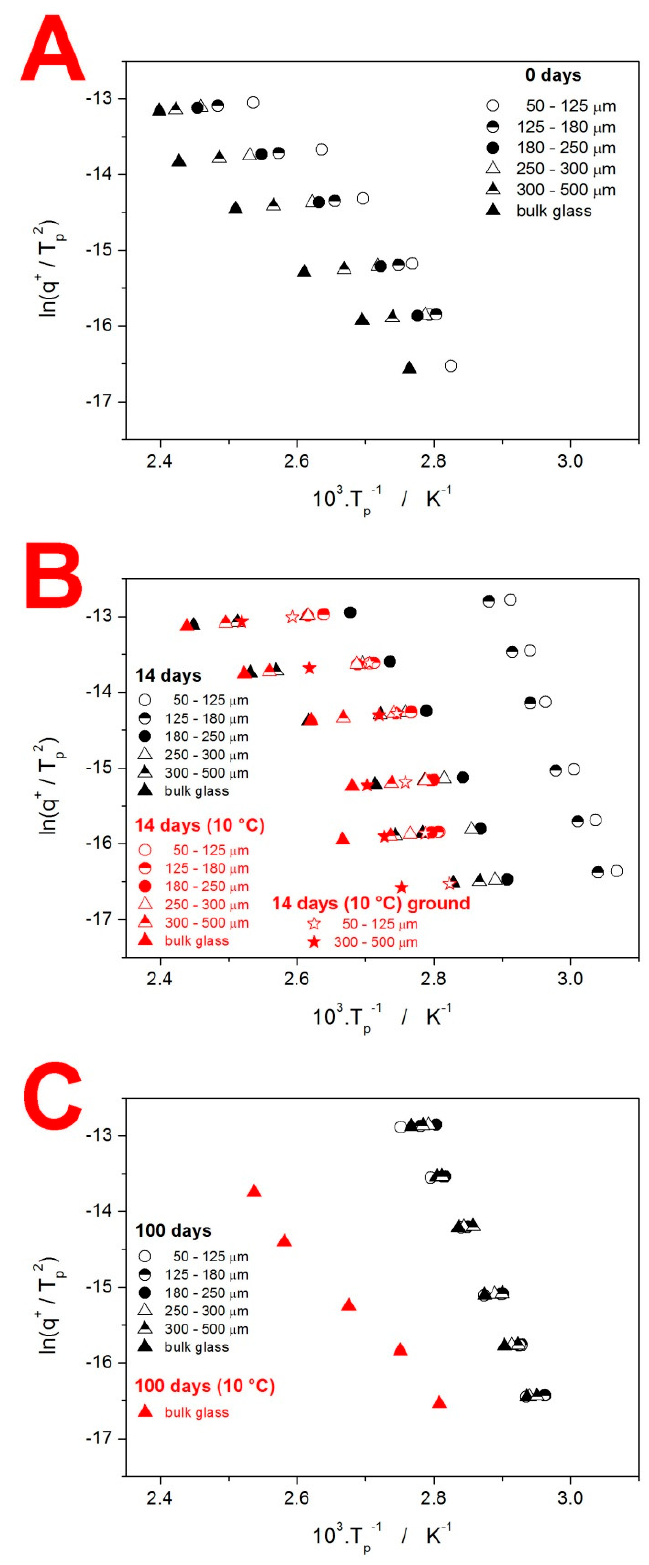
Figure 7. Kissinger plots for the IMC powders stored under different conditions. Each graph displays data for one time period: 0 days = as-prepared ( A ), 14 days ( B ), and 100 days ( C ).